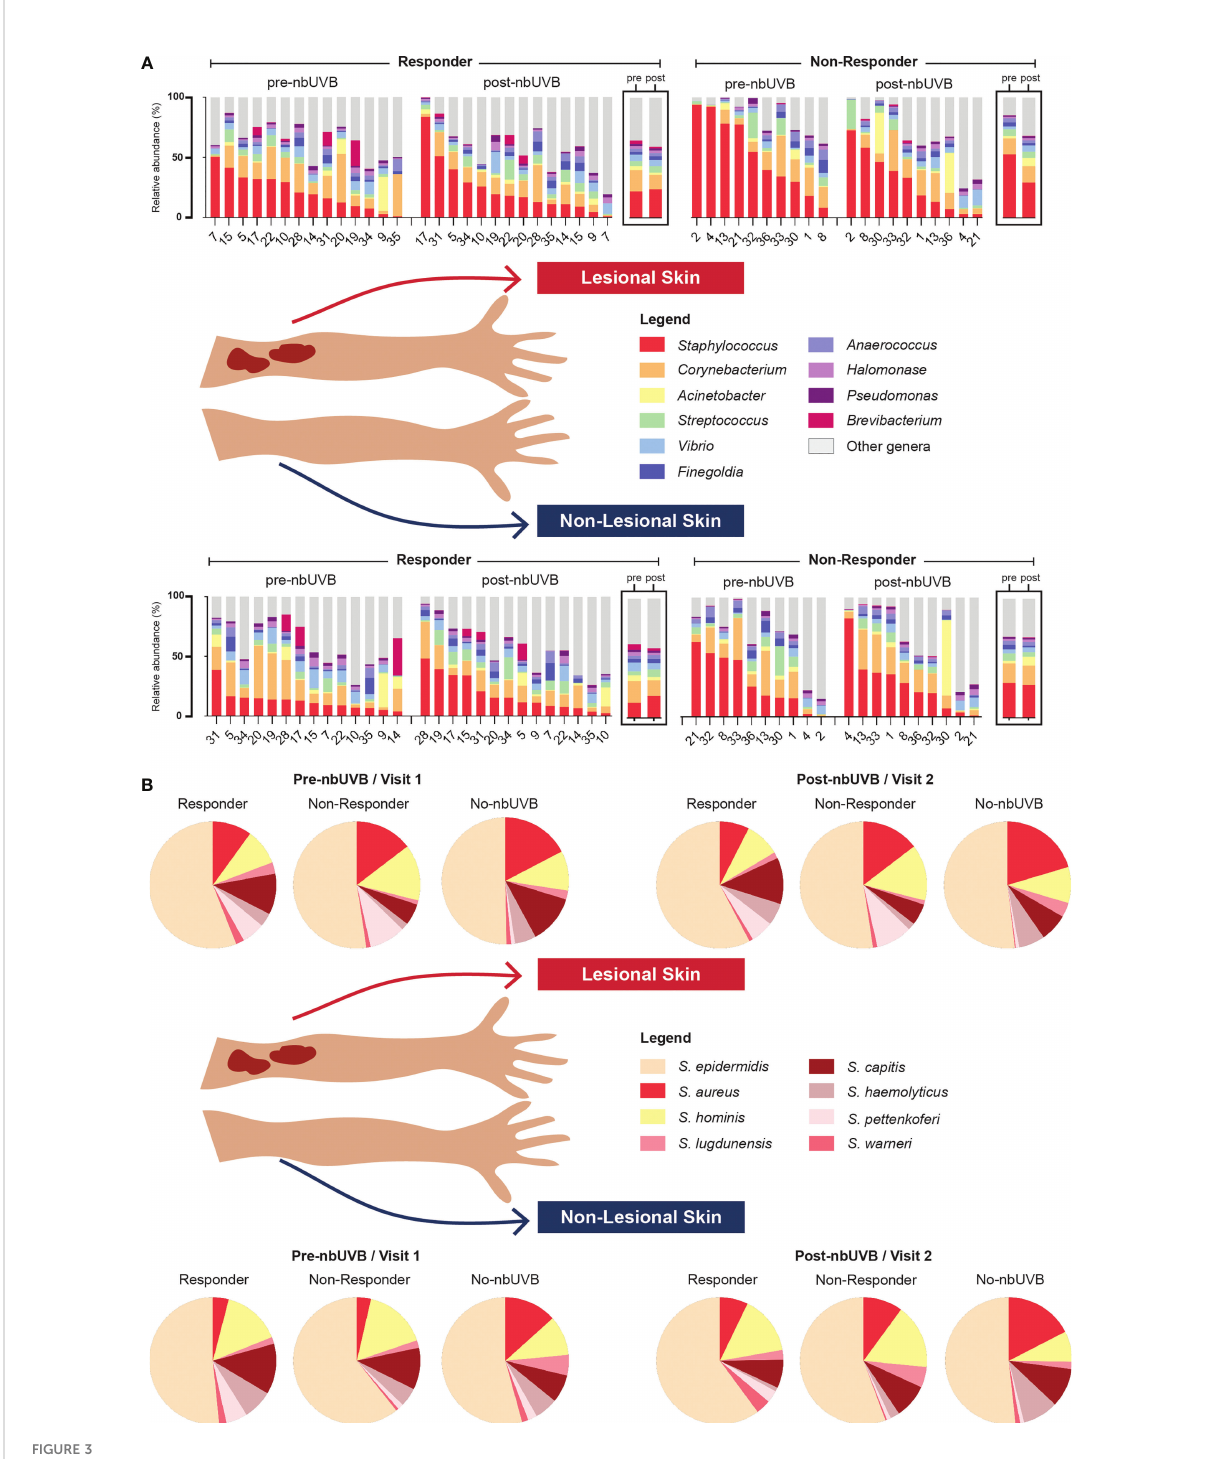
FIGURE 3 Microbial communities of CTCL lesional and non-lesional skin are predominated by different taxa. (A) At the taxonomic level of genus, Staphylococcus , Corynebacterium , and Acinetobacter were the most prevalent and abundant genera present in all treated samples. Bar charts indicate relative abundance (%) of the 10 most abundant genera populating the skin of each patient; boxed graphs re fl ect group mean relative abundance at pre-nbUVB (left) and post-nbUVB (right). Subject IDs are indicated along the x-axis and ordered to best visualize the distribution of relative abundances in descending order. Of note, this fi gure is not intended to illustrate statistically signi fi cant differences. (B) Staphylococcal speciation across all samples revealed a majority presence of S. epidermidis , S. aureus , and S. hominis . Pie charts re fl ect mean relative abundance of each species identi fi ed across R, NR, and no-nbUVB patient